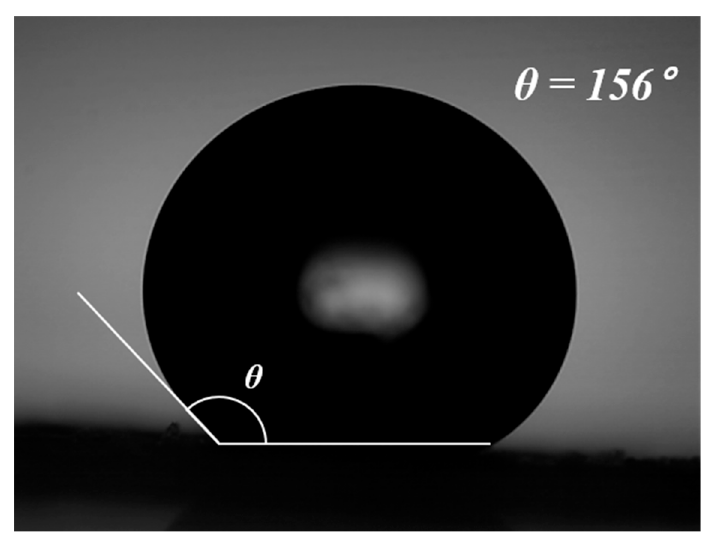
Figure 8. Water contact angle ( θ ) on the hydrophobic surface of the silica aerogel.